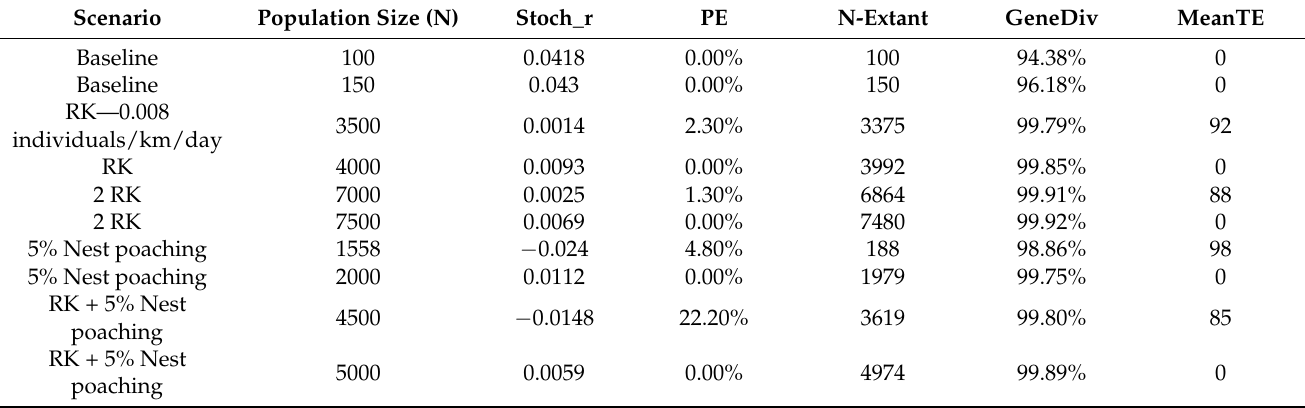
Table 4. Results of minimum viable population for blue-and-yellow macaw ( Ara ararauna ) in Emas National Park, Brazil, suffering from different levels of roadkill (RK) and nest poaching. Stoch_r: mean rate of stochastic population growth, PE: probability of extinction, N-extant: population size at the end of simulations, GeneDiv: genetic diversity, meanTE: mean time to extinction.